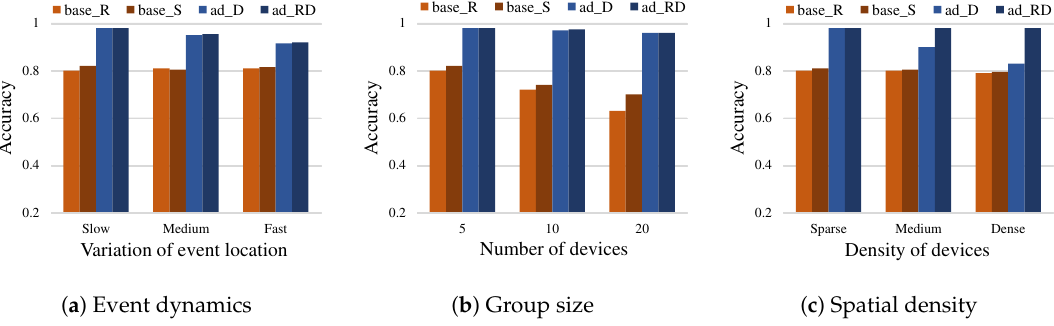
Figure 10. Accuracy by algorithms: having the test conditions in Table 3, the graphs show the accuracy by the algorithms implemented differently using Equations (2) and (6)–(10). The simulation was performed 1000 times for each pair of configuration and